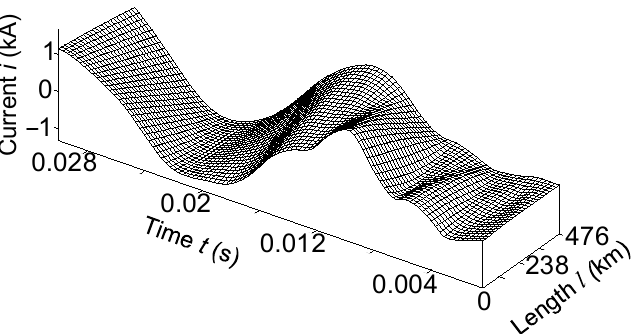
∈ (0; 0.03) s. Figure 7. Temporal-spatial current distribution of phase B in line at the time t